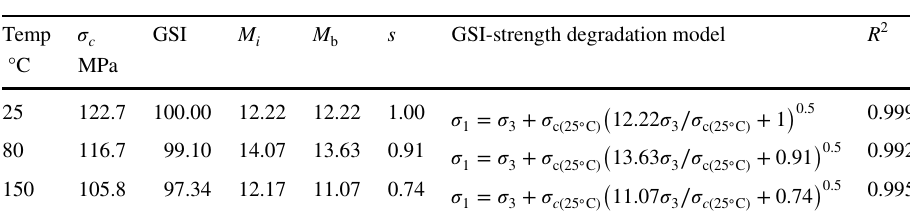
Table 2 Main parameters of GSI-Strength degradation model